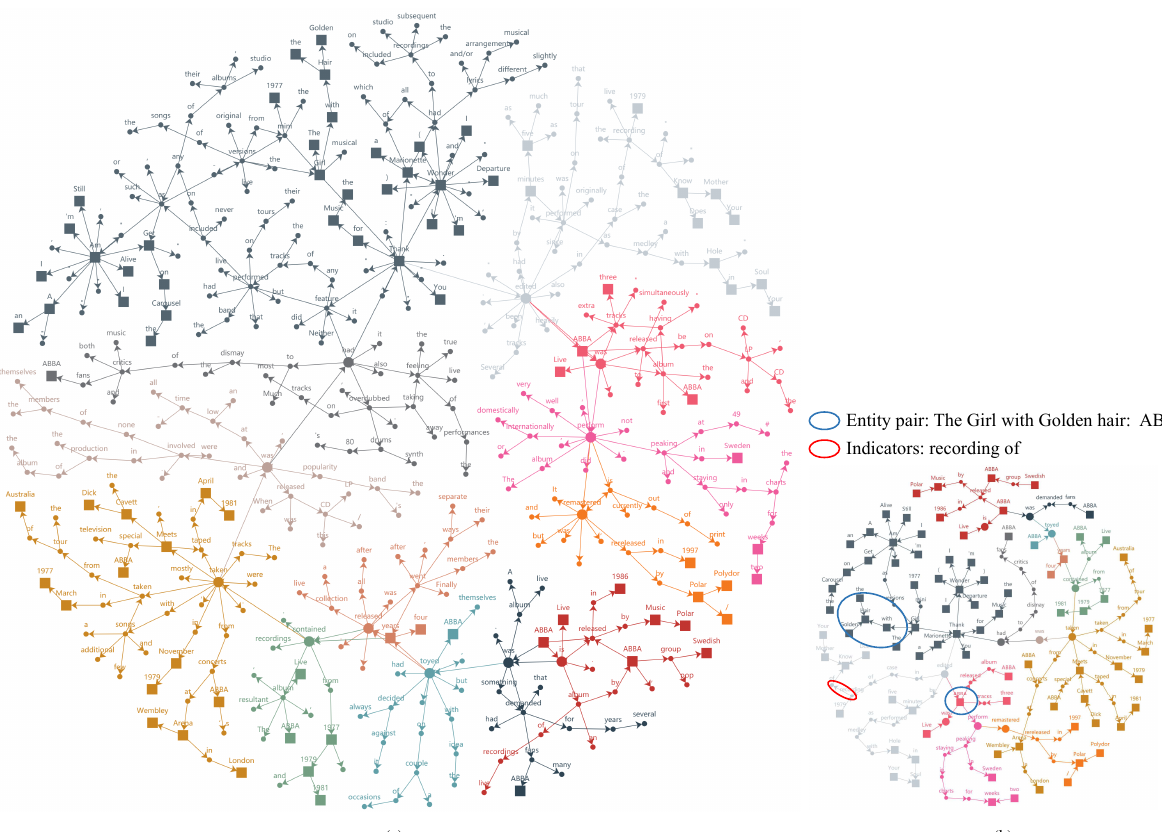
Fig. 5 (a) Example of the SDT-forest combining syntax and discourse dependency relations. (b) Example of the SG from (a) denoising words by the Steiner tree algorithm. The different colour nodes and links indicate different SDTs. The rectangular nodes refer to the entity mention. The others depict words in the document. All nodes connect through syntax, discourse, or “adjacent” relation.